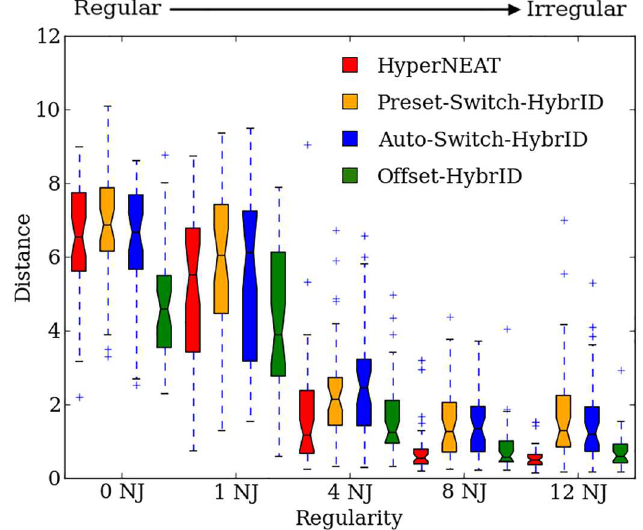
Fig 18. Final fitness per regularity for all methods on the quadruped robot experiment. The distance traveledby run championsafter 1,000 generationsfor each regularity(number of noisy joints) of the quadrupedrobot experiment.